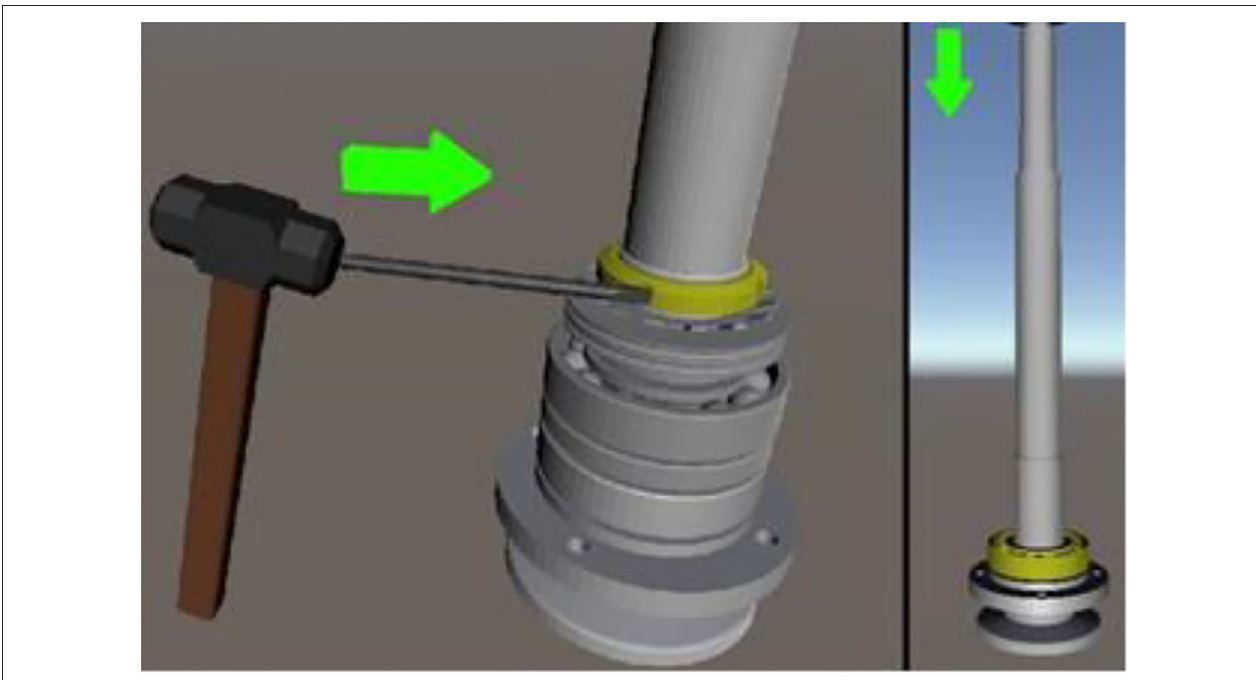
FIGURE 8 | SOP animation